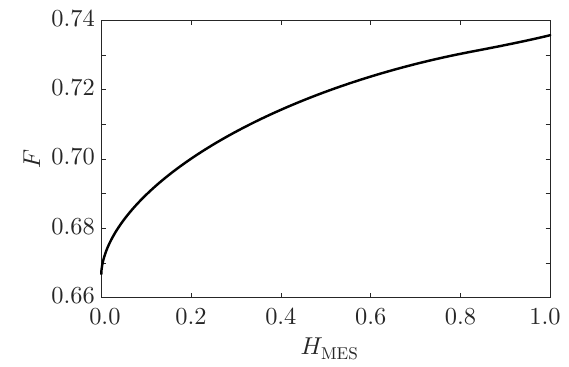
FIG. 5. Relation between the two-copy estimation fidelity and the minimum entropy sum. Here F is the two-copy estimation fidelity associated with two rank-1 projective measurements on a qubit as shown in Eq. (84), and H MES is the minimum entropy sum presented in Eq. (88), which characterizes the entropic uncertainty relation in Eq. (86).